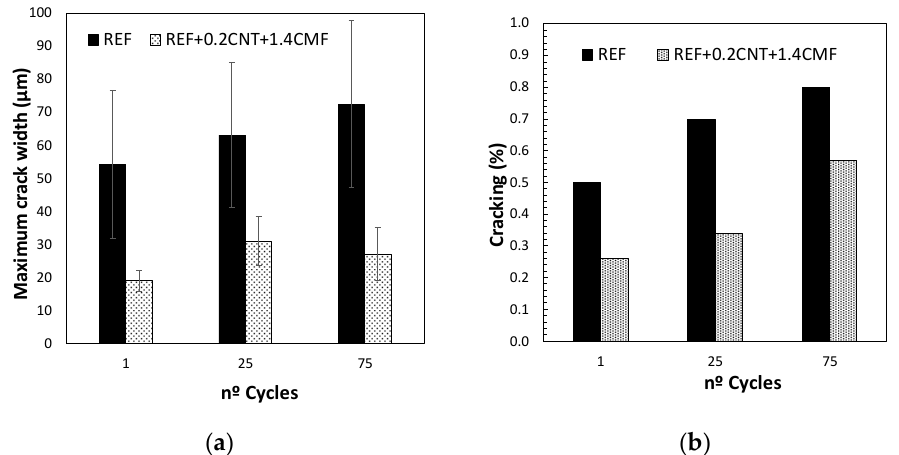
Figure 6. Maximum cracked width ( a ) and the percentage of cracked area after 1.25 and 75 heating/cooling cycles ( b ).